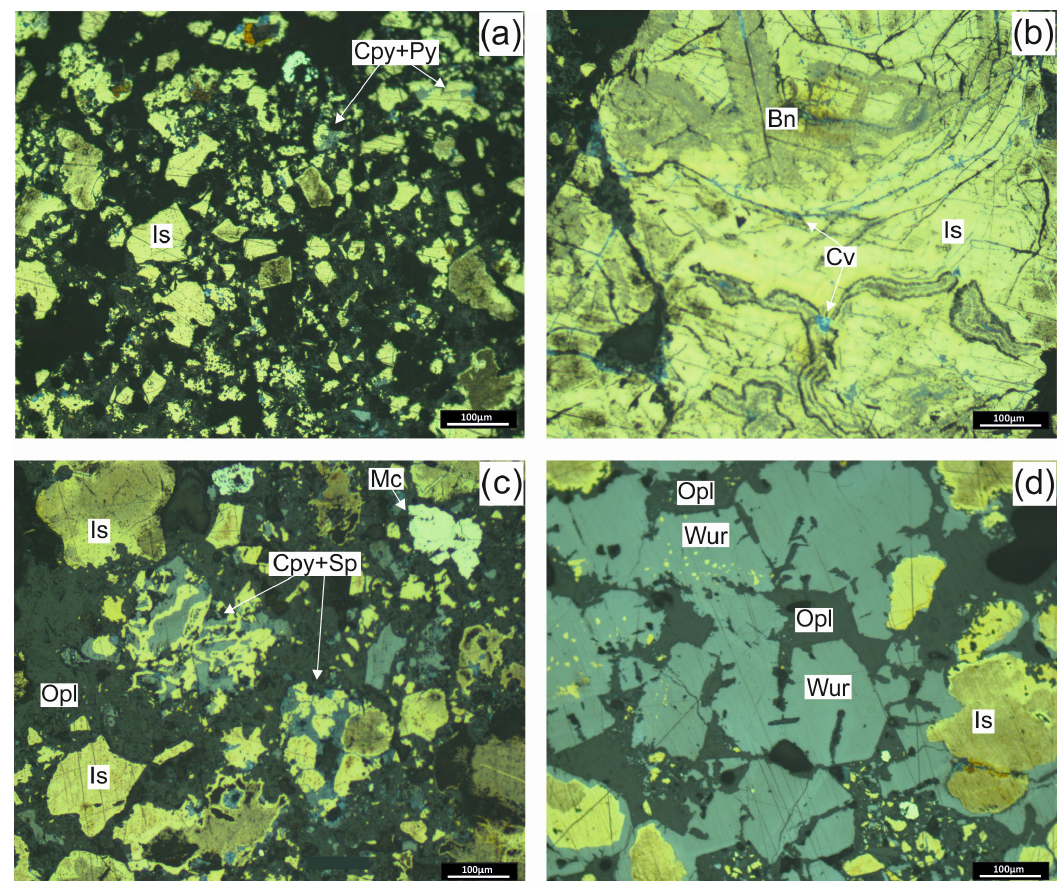
Figure 10. Sphalerite-wurtzite-chalcopyrite-isocubanite breccias with opal cement. Reflected light photographs. ( a ) Small clasts of altered isocubanite in opal cement (287-B-1 / 2); ( b ) Alteration of isocubanite (Is) along fissures, where its central parts are composed of covellite (Cv) (287-B-1 / 2); ( c ) Clasts of altered isocubanite (Is), along with chalcopyrite-sphalerite intergrowths (Cpy-Sp), Zn-sulphides and pyrite-marcasite clasts (287-B -2 / 1); ( d ) Wurtzite (Wur) crystals in opal cements around the channel (Opl) (287-B-2 / 1).